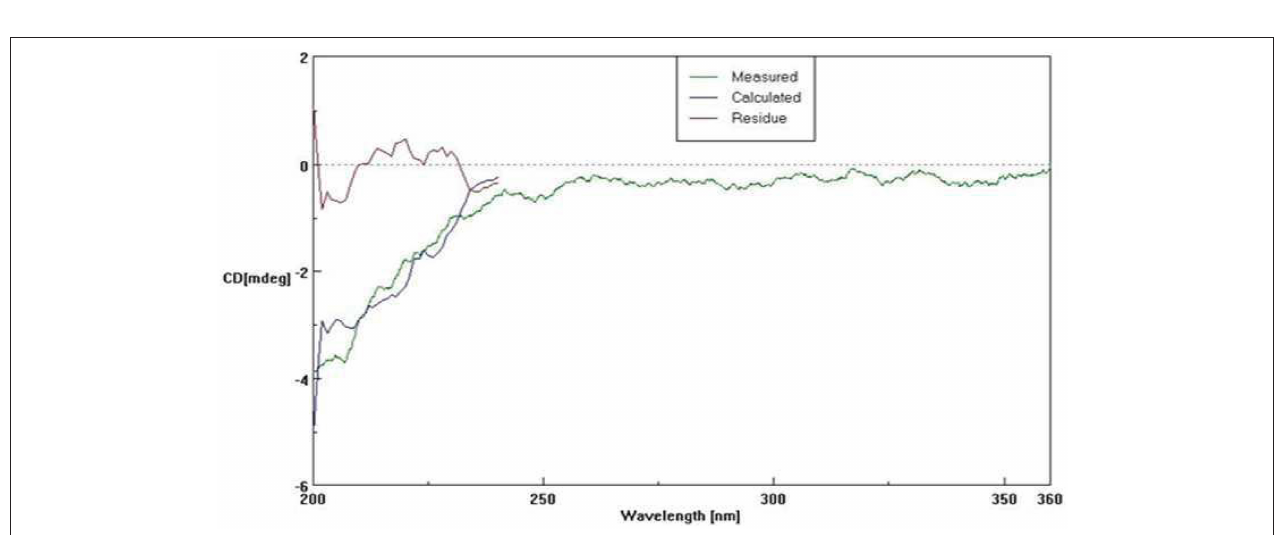
FIGURE 3 | Electrophoretic analysis of amylase. (A), M , Marker; CA , Crude amylase; (B), M , Marker; PA , Purified amylase; ZA , Zymographic analysis of amylase.